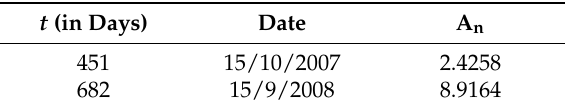
Table 15. Change points for the estimated positive jumps of Intel with the corresponding test statistic value.